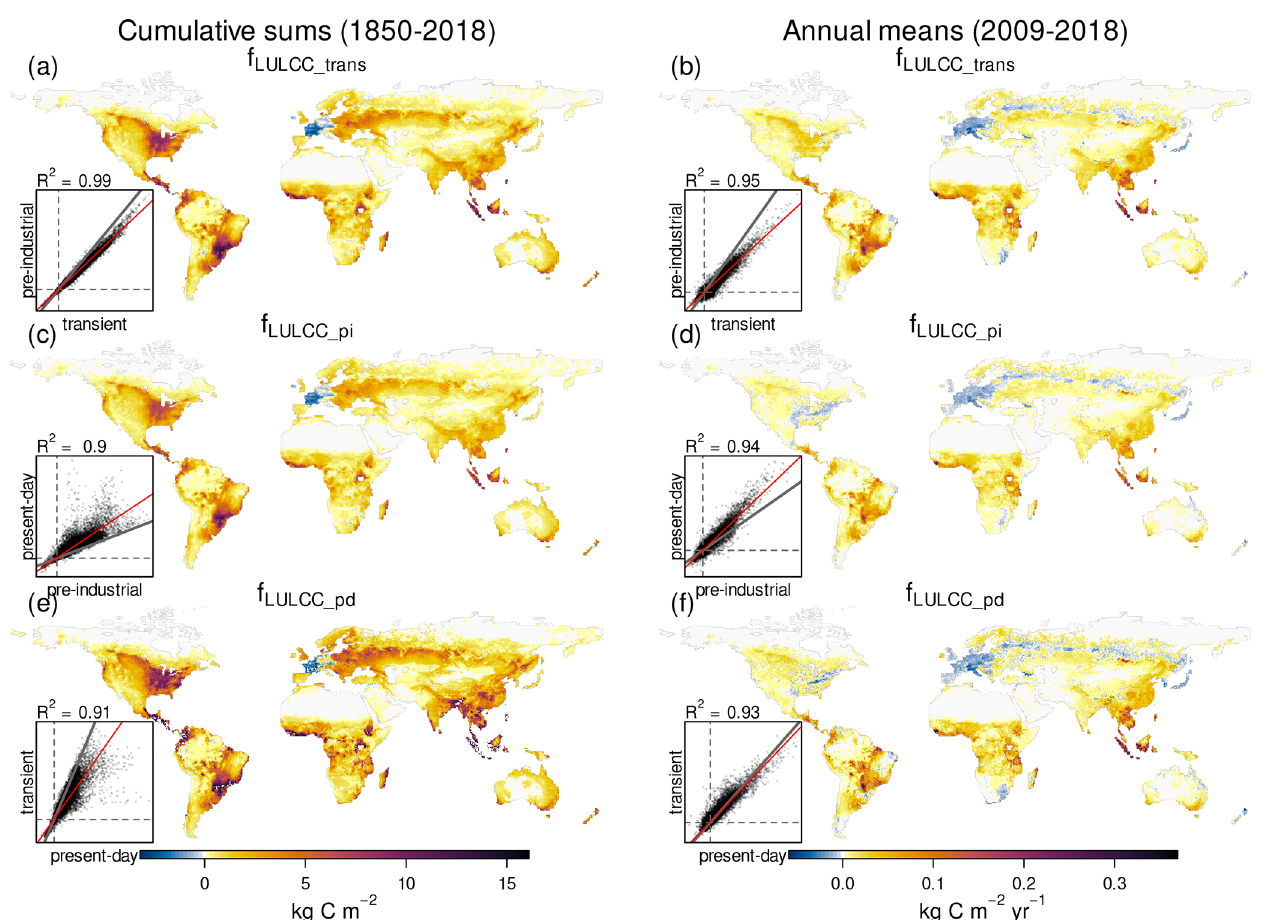
Figure 9. Cumulative sums from 1850 onward (a, c, e) and annual means for 2009–2018 (b, d, f) of f LULCC_trans (a, b) , f LULCC_pi (c, d) , and f LULCC_pd (e, f) averaged across the models. Additionally, correlation plots between the pixel-wise estimations are shown; here, the grey line represents the 1 : 1 line, the dashed grey lines depict zero lines, and the red line shows a fitted linear model. f LULCC_pd was not derived for CLM5.0, JULES, LPJ, and OCN models (compare Table